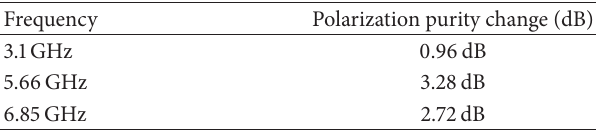
Table 2: Polarization purity change in presence of